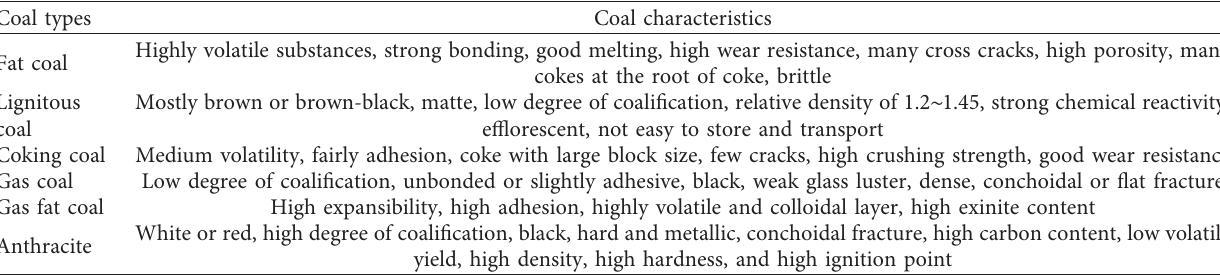
Table 1: Analysis of coal types and